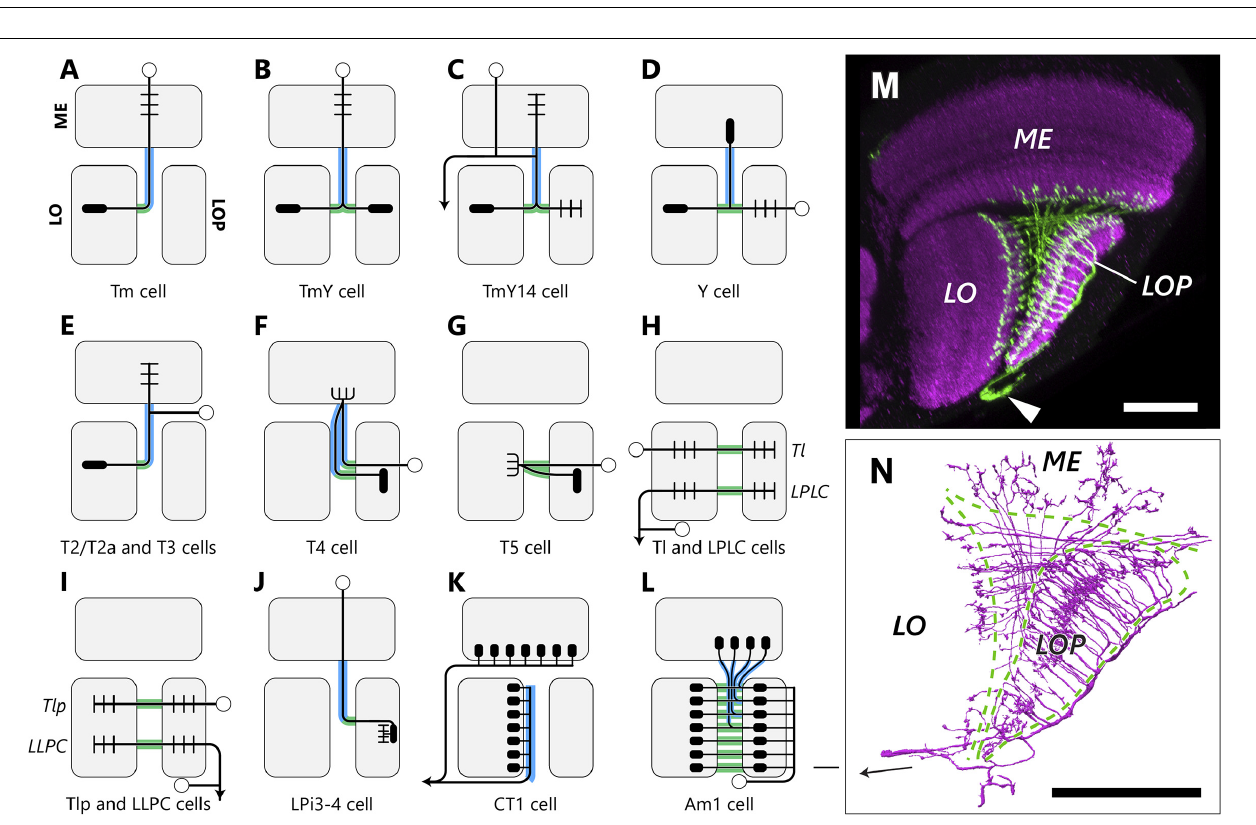
FIGURE 2 | Continued repo-GAL4 > GFP, while synaptic neuropils (blue) are labeled with anti-Brp (nc82 antibody). Arrowheads indicate the bundles of fibers surrounded by glial processes. PLP: posterior lateral protocerebrum. (D) A model of the bundles and sheets of OCH2. Fibers in the bundles (shown in blue), running vertically in the panel, connect the medulla and lobula complex, and those in the sheets (shown in green) connect the lobula and lobula plate. Note that axons between the medulla and lobula complex defasciculate from their bundles and merge into the sheets, before projecting to the lobula complex neuropils. The bundle therefore becomes thinner as it runs deeper into the OCH2. Examples of T4 (pink), Tm (yellow), and TmY (orange, brown) cells are in different colors. (E) Cross section image of the bundles and sheets, cut perpendicular to the bundles and in parallel to the sheets. The bundles are labeled in blue, the sheets in green, and major glial processes surrounding the structures in red for (E) and (F) . (F) Cross section of the chiasm, cut in parallel to the bundles and perpendicular to the sheets in a plane rotated 90 ◦ from that in (E) . Cell bodies of glia are indicated by asterisks. Scale bar: (A,C) 30 µ m, (E,F) 10 µ m. Axes shown in (A) , (C) , (E) , and (F) are based on the body axis.